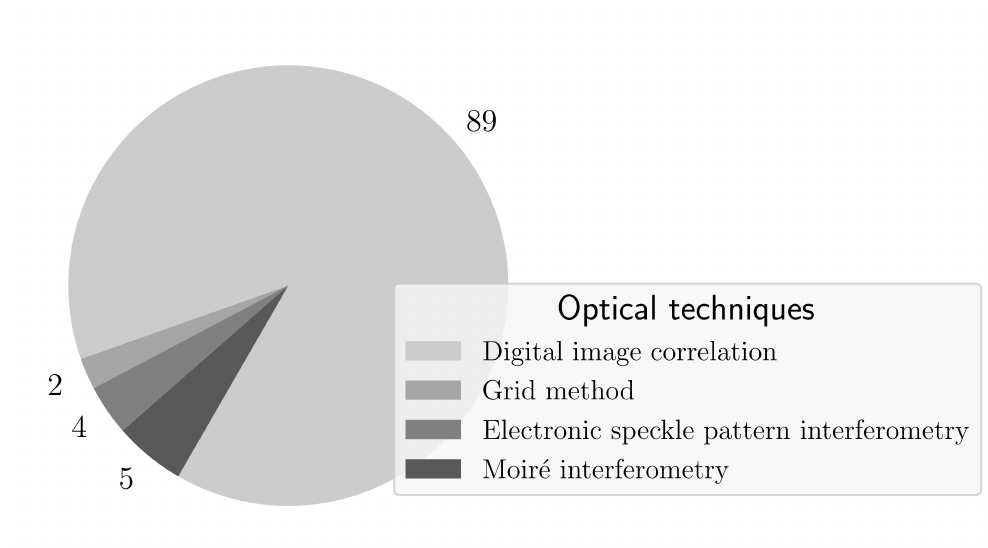
Figure 1. Number of publications in Scopus for different full-field optical techniques coupled with the searching keyword in situ measurements (units: